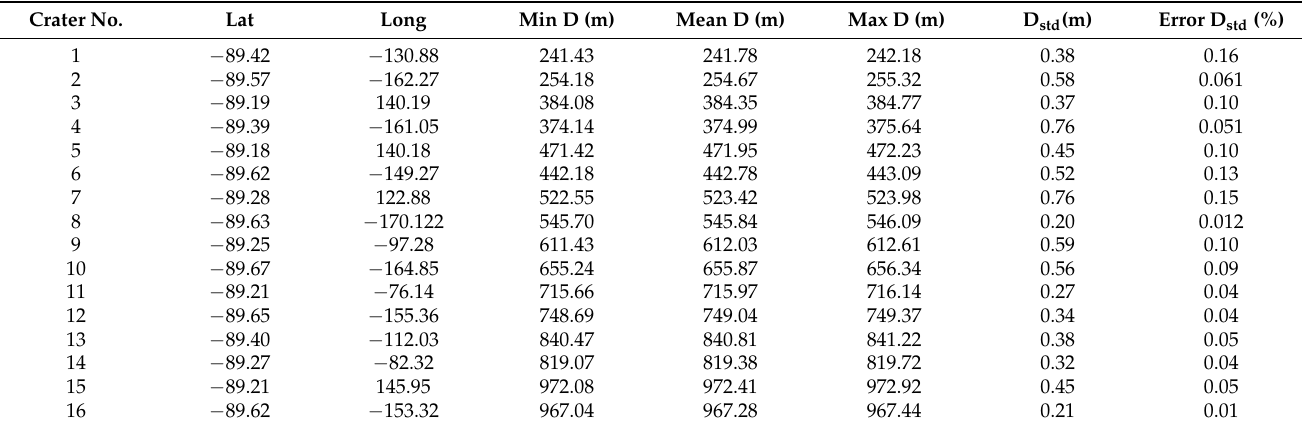
Table 1. Crater statistics used in the uncertainties